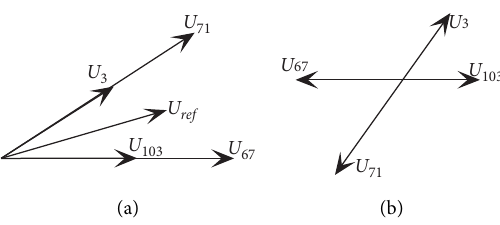
Figure 3: NFV-SVPWM vector synthesis. (a) Fundamental wave subspace. (b) The 3rd harmonic